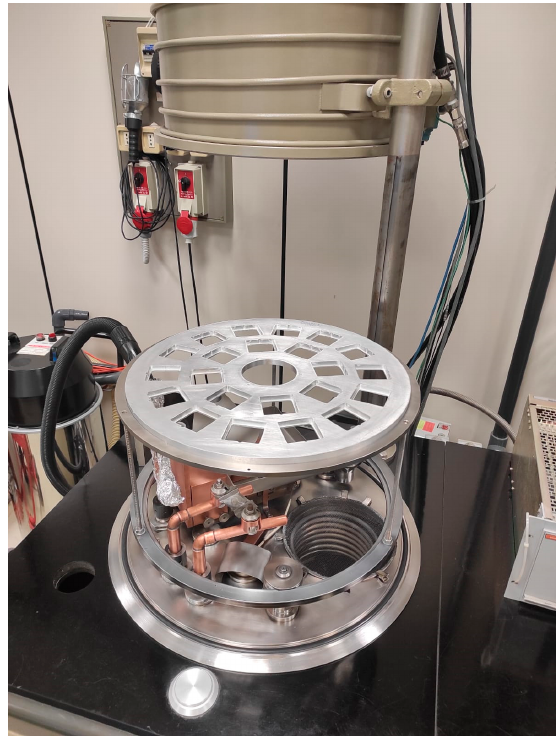
Figure 10. The 50 cm diameter evaporator with support for 22 substrates.